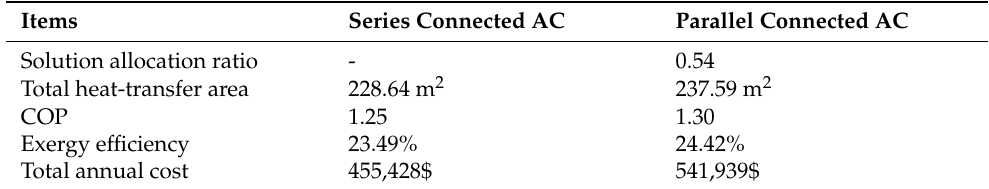
Table 6. Main simulation results of the two AC types (cooling capacity 400